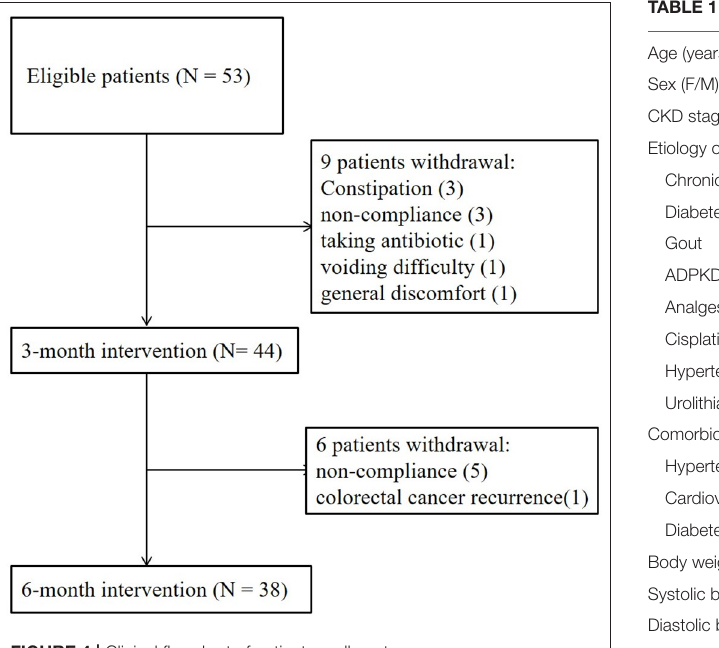
FIGURE 4 | Clinical flowchart of patient enrollment.